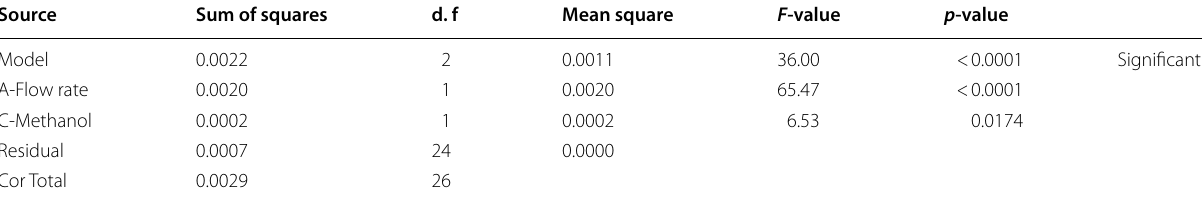
Table 7 ANOVA results for Response 3: TF Source